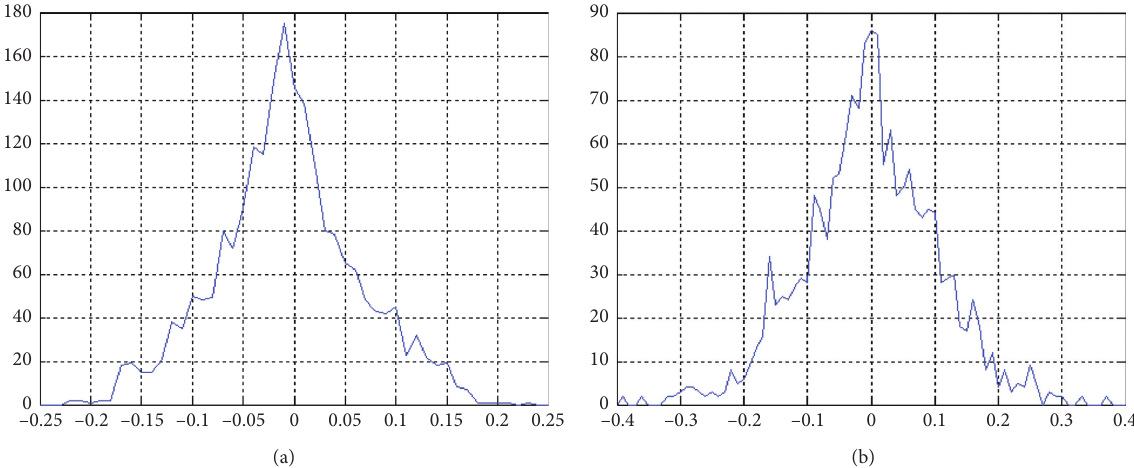
Figure 5: Comparison of RSSI difference. (a) The RSSI ratio at t value; Y : frequency of